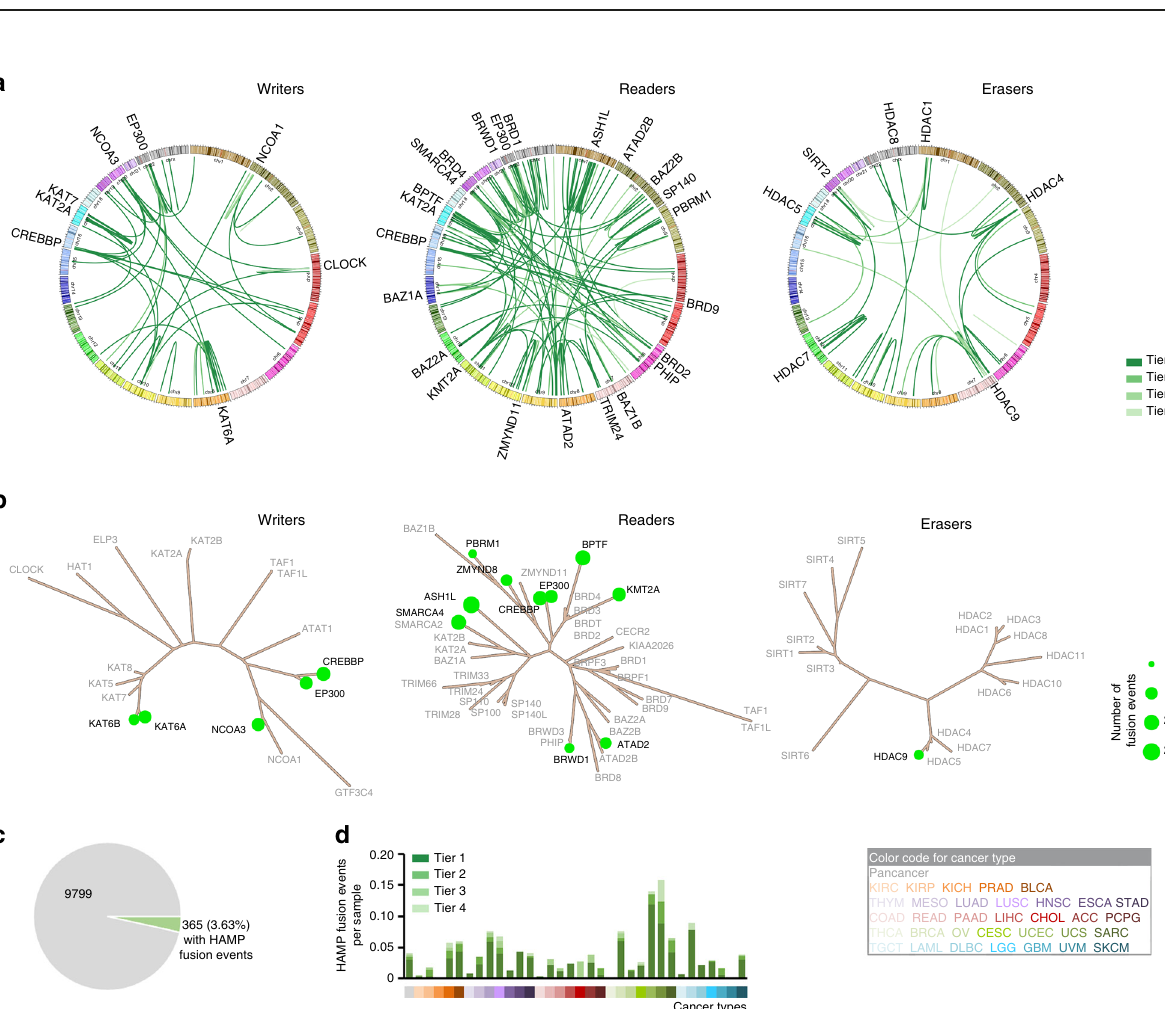
Fig. 5 The putative cancer-causing HAMPs driven by somatic mutations across cancers. a Overall M-scores of the seven putative cancer-causing HAMPs (M-scores > 0.4) across all cancer types. b – e The fractions of the mutation categories ( b ), types ( c ), timing status ( d ), and clonal heterogeneity ( e ) of the seven HAMPs across all cancer types. f The lollipop plots illustrate the distribution and categories of somatic mutations in the EP300 , CREBBP , and PBRM1 gene-coding sequences across all cancer types. Note that although mutations are randomly distributed along the entire coding sequence, in both the EP300 and CREBBP genes the most frequent mutations are located within the HAT catalytic domain. g – j The fractions of the mutation categories ( g ), types ( h ), timing status ( i ), and clonal heterogeneity ( j ) of EP300 , CREBBP , and PBRM1 in individual cancer types. k Clonal heterogeneity of EP300 , CREBBP , and PBRM1 across cancers. On the basis of the probability distributions of the cancer cell fractions, mutations were determined to be either clonal (red blocks) or subclonal (blue blocks). l An example of a meta-domain represented 51 different BRDs within BRD-containing genes. The x -axis shows the amino acid positions of the alignment. The y -axis, from top to bottom panel, indicates the mutation number of each position, the signi fi cance of a mutation in a given position (LowMACA), the amino acid conservation of the meta-domain, and the Pfam hidden Markov model sequence logo generated via the Skylign tool where the height of each stack of residues indicates the relative entropy for that position. m Bar plots showing the stacking of mutations within the six main HAMP Pfam domains. The x -axis depicts the position in the global alignment and the y -axis shows the mutation number of each position. The red bars highlight the residues that are signi fi cant according to the Benjamini – Hochberg procedure for multiple testing correction of p -values, which we performed on the conserved positions using LowMACA. n Ribbon drawings of the crystal structures of the HAT_KAT11 domain within EP300 (3BIY) and Bromodomain within PBRM1 (3G0J). The D1399 and R710 residues that were identi fi ed as hotspot mutations are shown